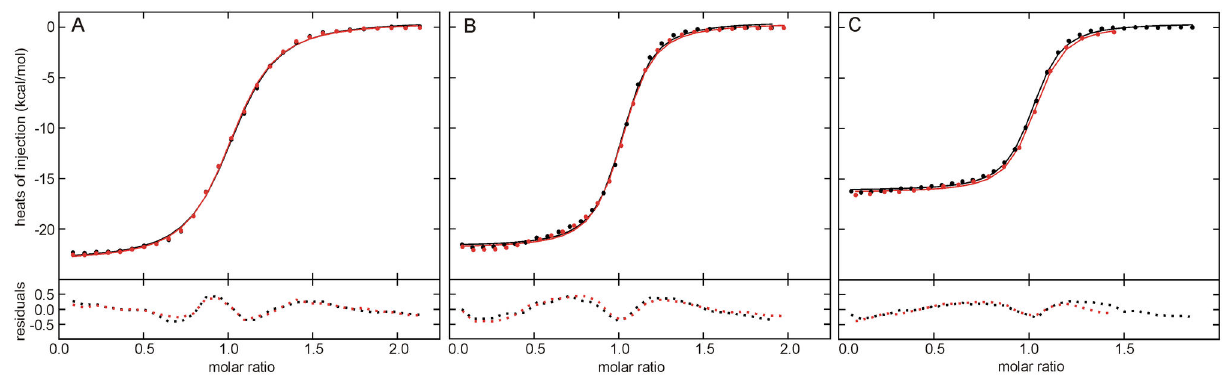
Figure 3. ITC binding isotherms from titrations of FMN, RF and FAD with Apo-YLOV. Titrations of 400 µM Apo-YLOV into 40 µM FMN (A), 40 µM RF (B) and 40 µM FAD (C) were performed twice and heats of reaction are represented in the upper diagrams by black and red dots, respectively. All titration curves were fitted for a single binding site.The individual binding isotherms (black and red lines) were obtained from a global fit of the combined data from experiments belonging to titrations with the same flavin. The corresponding residuals (rmsd) are displayed at the bottom. All calculated values are given in Table 2. doi: